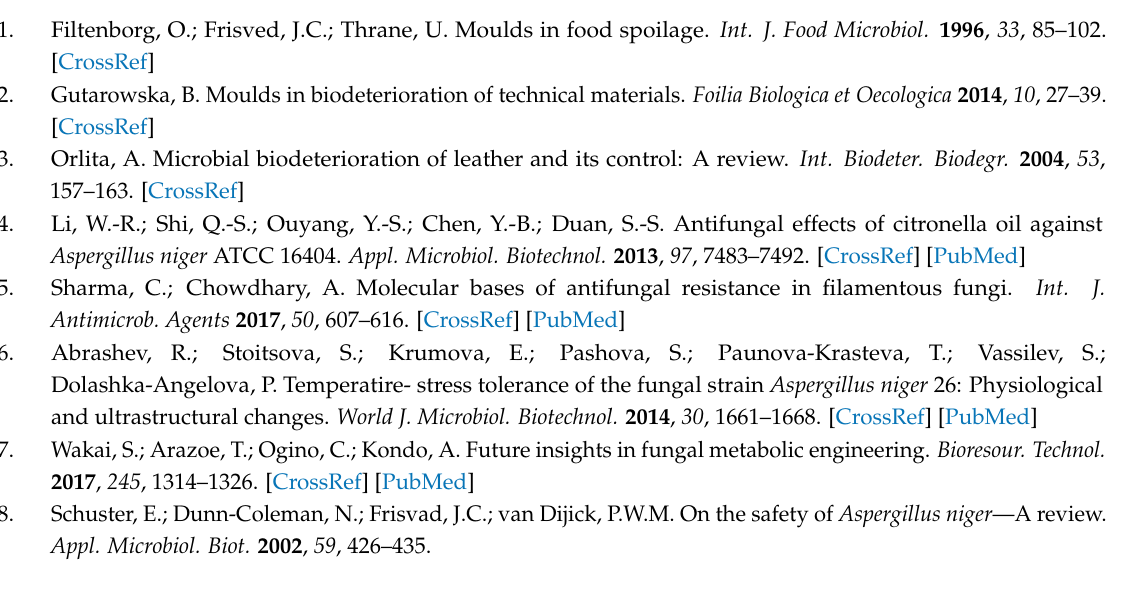
Figure S1: SDS-PAGE analysis of extracellular protein profiles of untreated A. brasiliensis ATCC 16404 (K – control samples) and treated with neutral (A5 and A6) and cationic (C5 and C6) gemini surfactants. M – molecular weight standard (PageRuler™ Unstained Broad Range Protein